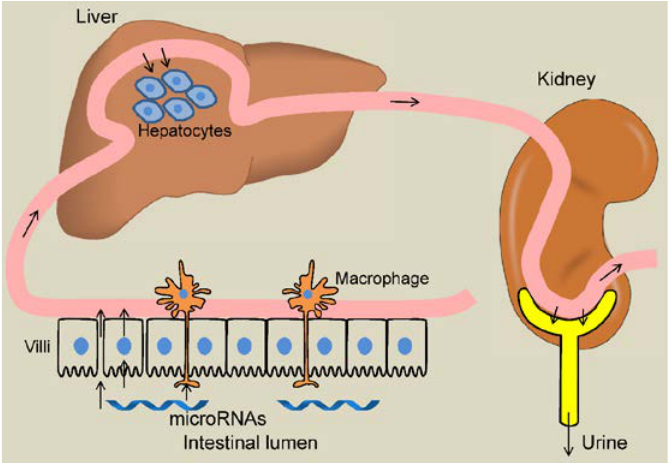
Figure 1. Model of dietary microRNA dynamics within the consumer. Dietary microRNAs, in order to be detected in circulation and tissues, must circumvent degradation by the gut; transverse the intestinal barrier (possibly through active transport across intestinal epithelial layers, via leaky gut lining, or trafficked by the immune cells patrolling the gut); withstand degradation in circulation; survive sequestration into and metabolism by the tissues such as the liver; and survive filtration and excretion at the